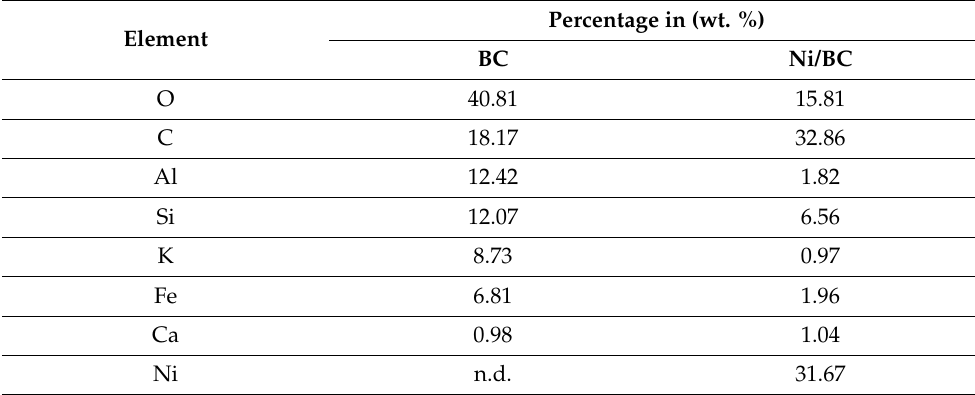
Table 1. Elemental analysis of BC and Ni/BC from EDX analysis.